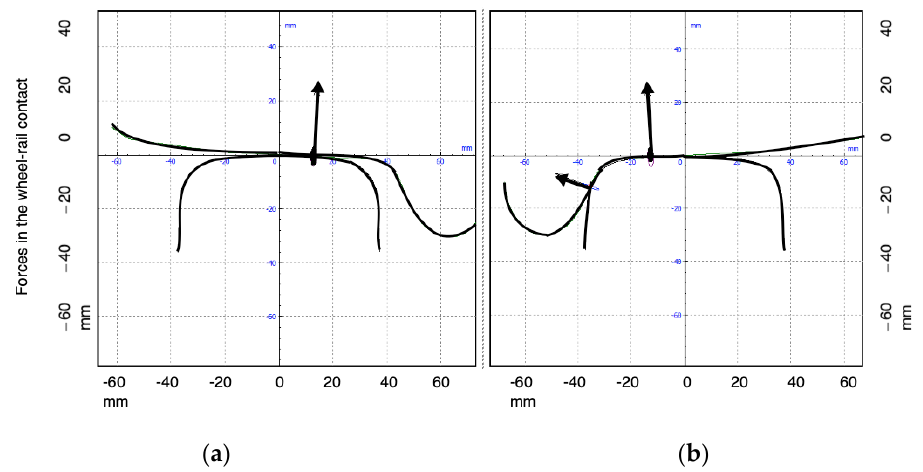
Figure 20. Forces in the wheel – rail contact and their position in the left turn.